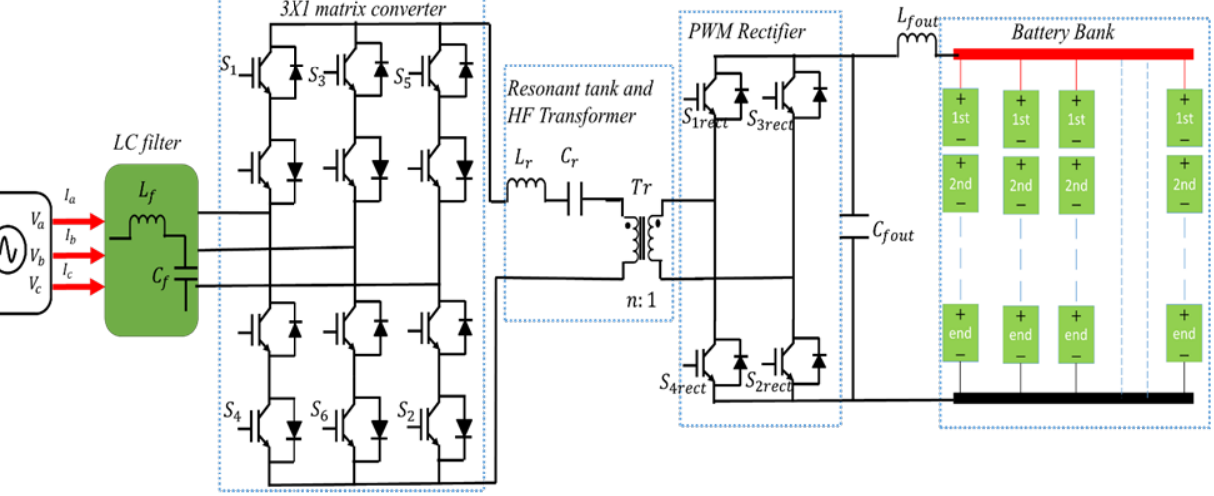
Figure 6. Matrix converter topology with resonant tank and HF transformer for EV charger.